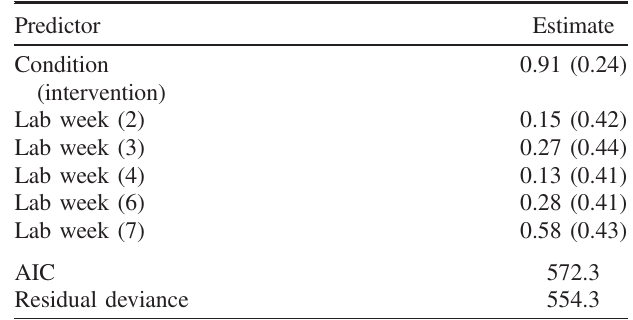
TABLE VII. Ordinal logistic regression analysis for the tone of students ’ descriptions of their methods between conditions and over time. The variable estimate is listed with its standard error for models with and without interaction terms. The base is a student in the control condition in week